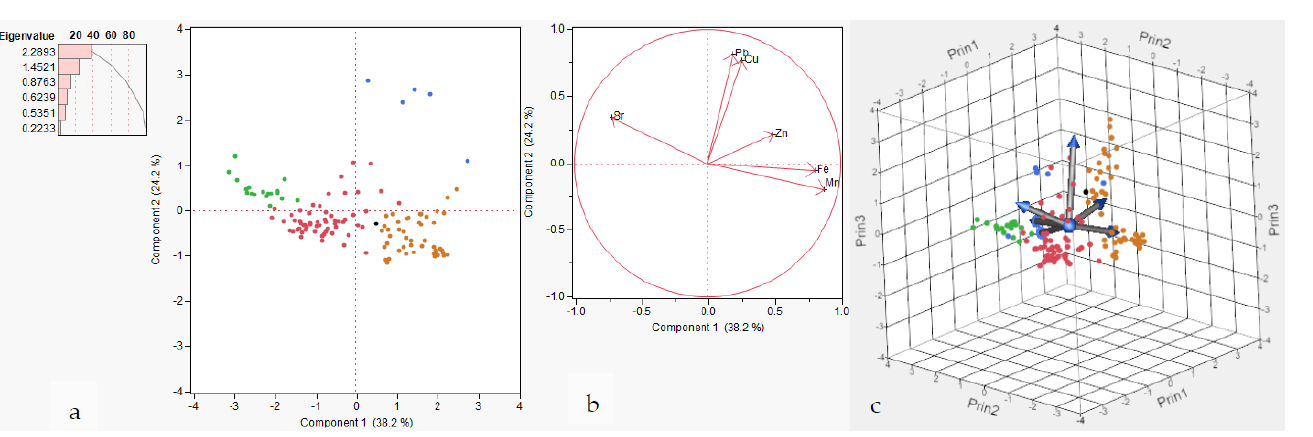
Figure 2. (a ) Biplot, ( b ) Principal Components Loading Plot, and ( c ) 3D Scatterplot showing Principal 1, Principal 2, and Principal 3.